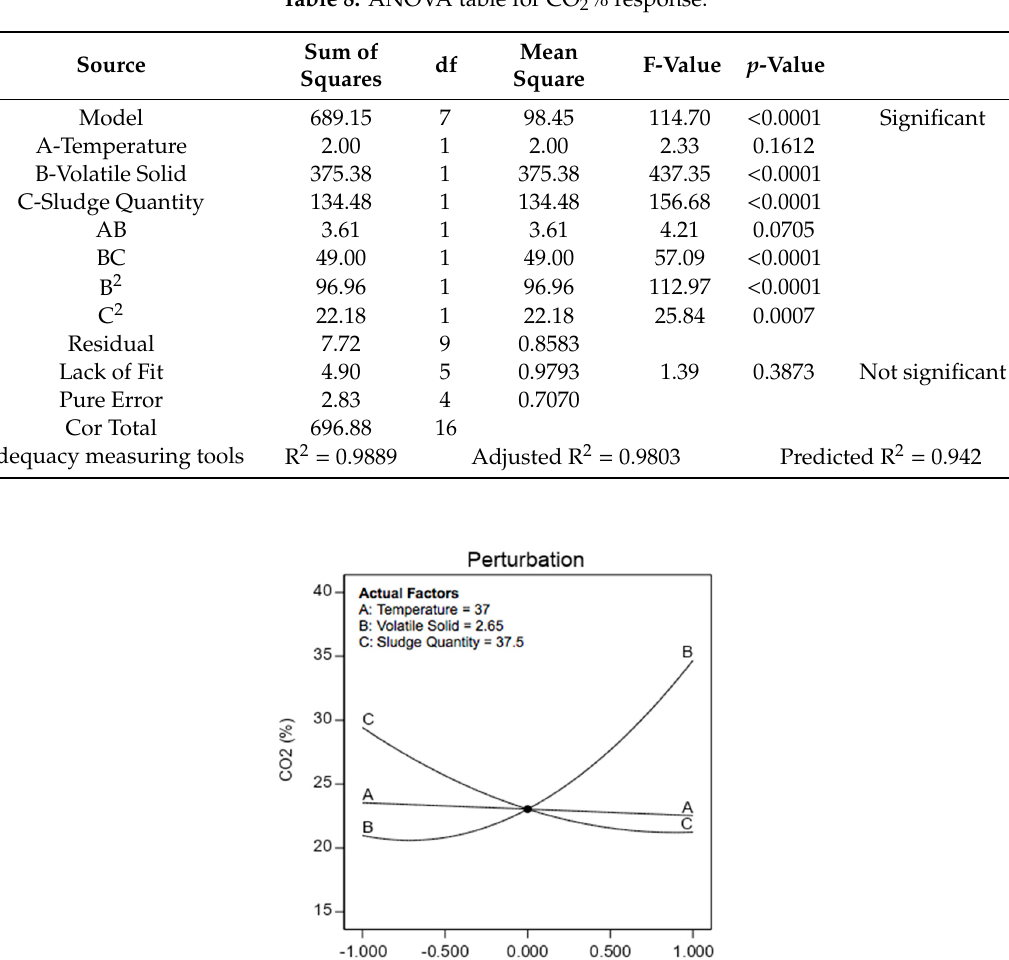
Table 8. ANOVA table for CO 2 % response.